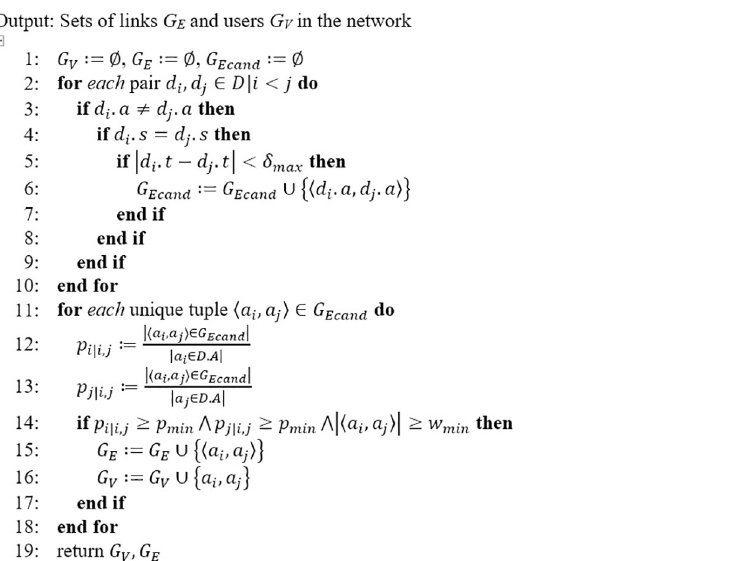
Fig 1. Algorithm for spatial-temporal social network